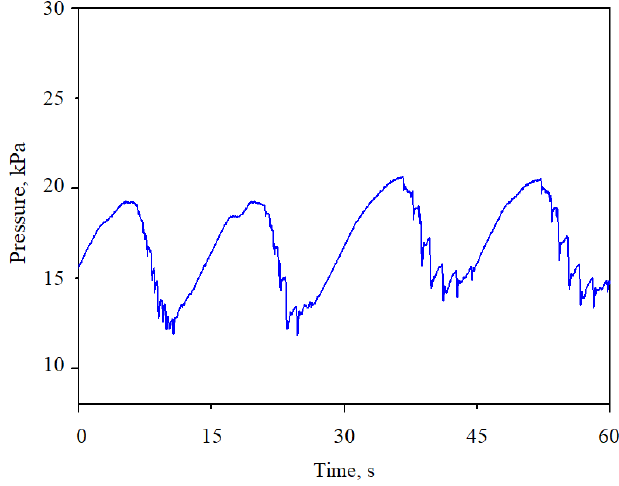
Figure 3. Measured pressure at riser-base during choking-induced slug flow ( U GS = 0.08 m/s and U LS = 0.09 m/s).